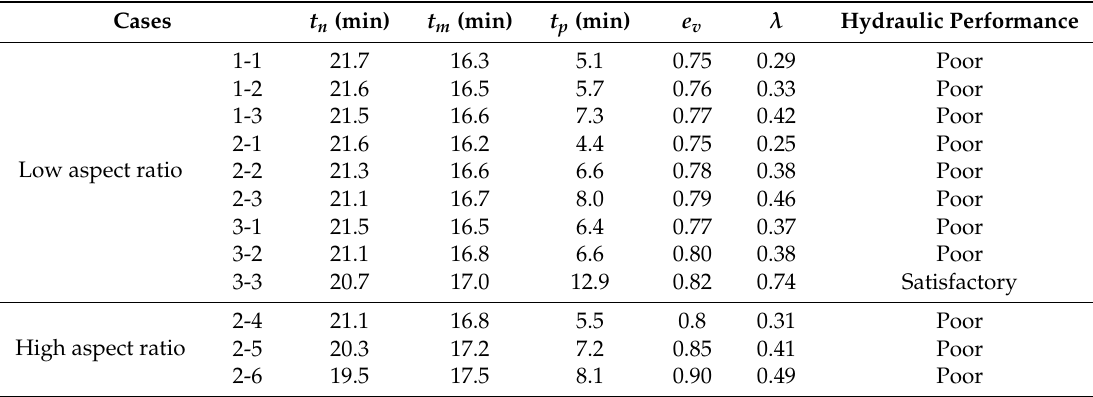
Table 4. Nominal retention time, mean residence time, peak time, effective volume, and hydraulic efficiency of cases with submerged